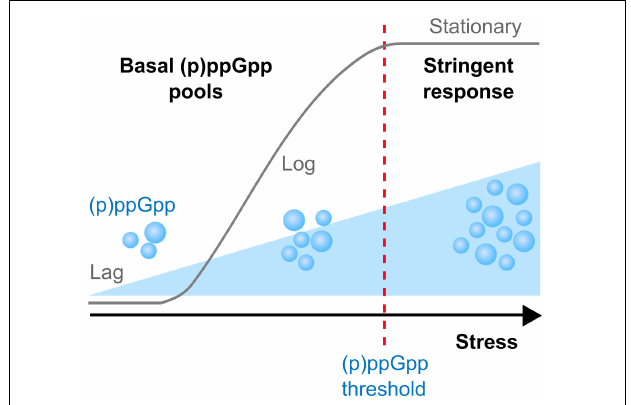
FIGURE 1 | (p)ppGpp modulates bacterial physiology at all growth stages. During adaptation (lag) and exponential (log) growth phases in the absence of stresses, basal levels of (p)ppGpp are important to maintain a balanced metabolism avoiding uncontrolled consumption of energy stores and toxic accumulation of metabolic byproducts. Entry into stationary growth phase or adverse condtions such as nutrient starvation, heat shock or selected antibiotic stresses triggers the accumulation of (p)ppGpp that rapidly reaches the threshold necessary to mount the SR responsible for remodeling cell physiology from a growth mode to a survival